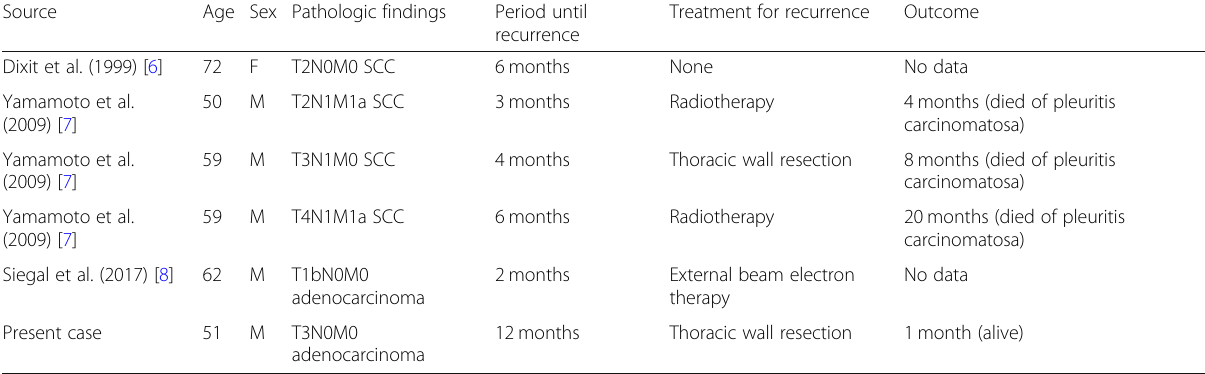
Table 1 Literature review of cases with port site recurrence of esophageal carcinoma after esophagectomy